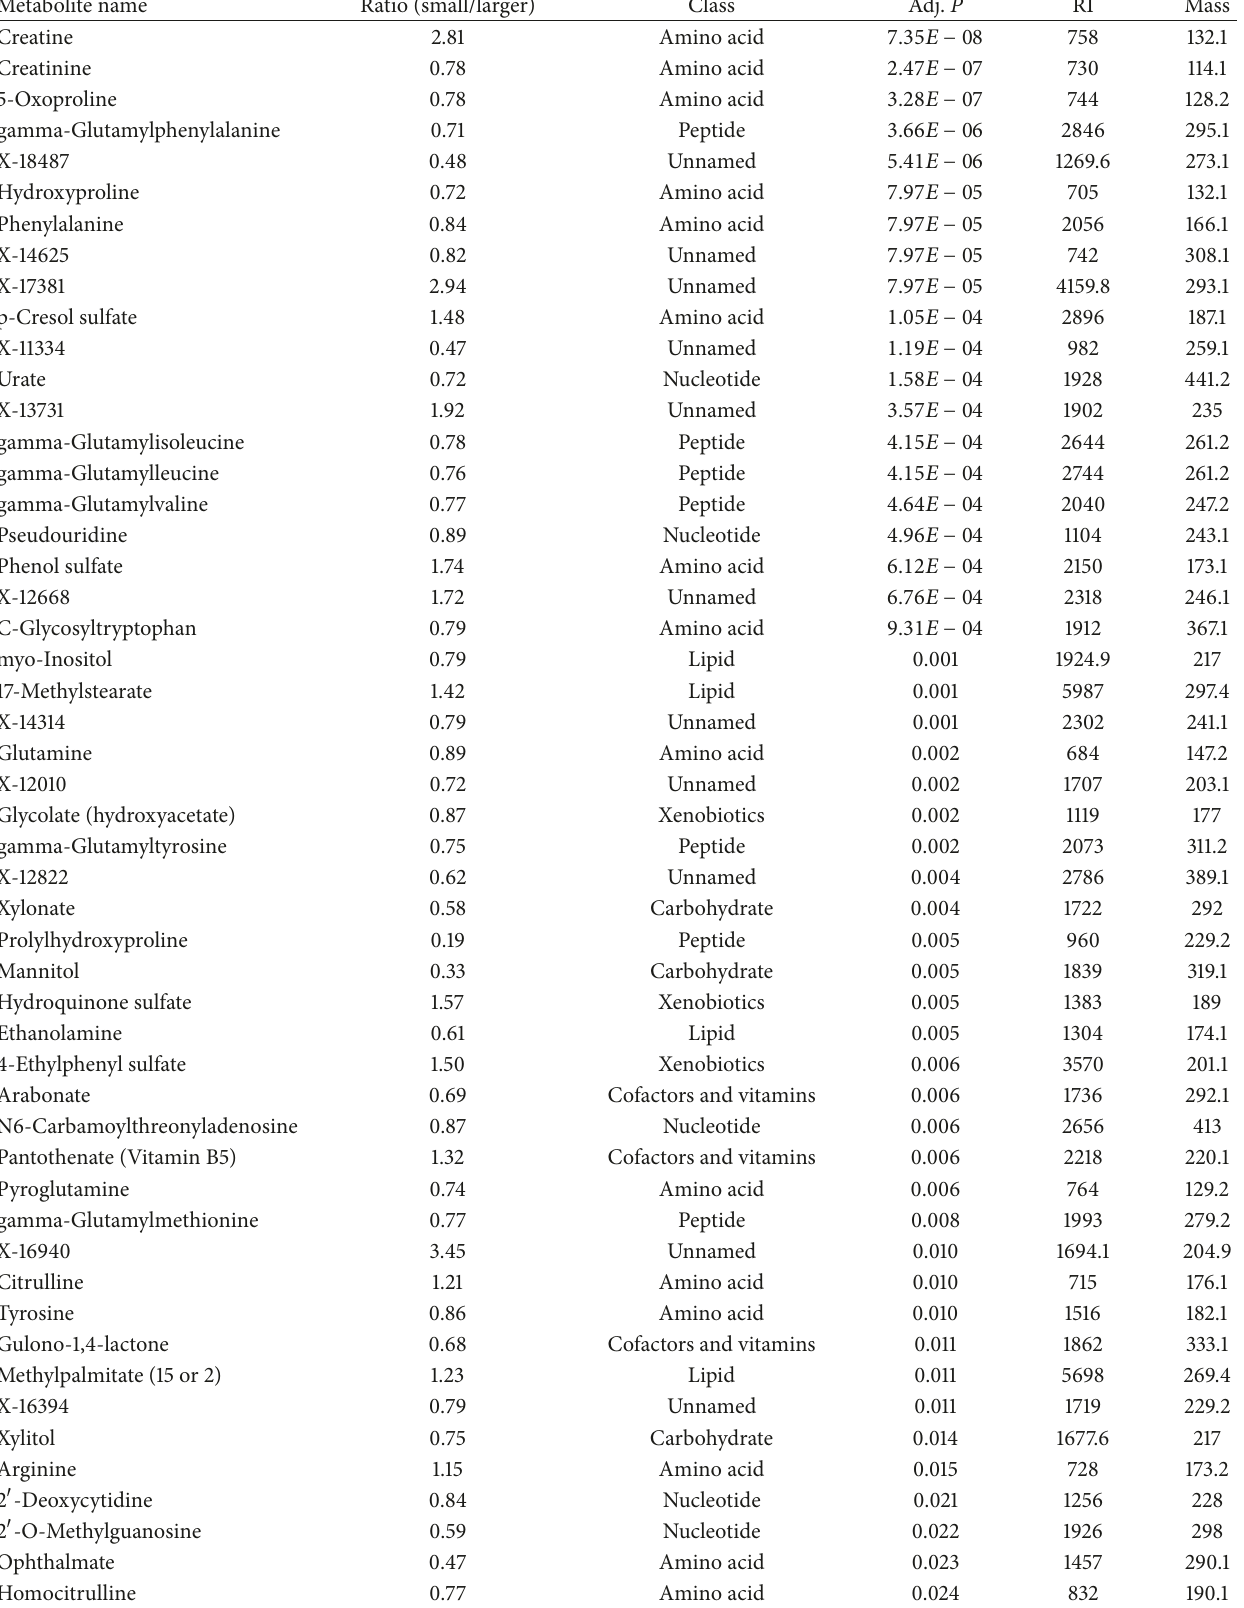
Table 1: Plasma metabolites with adjusted 𝑃 value < 0.05 between small dogs and dogs of larger body